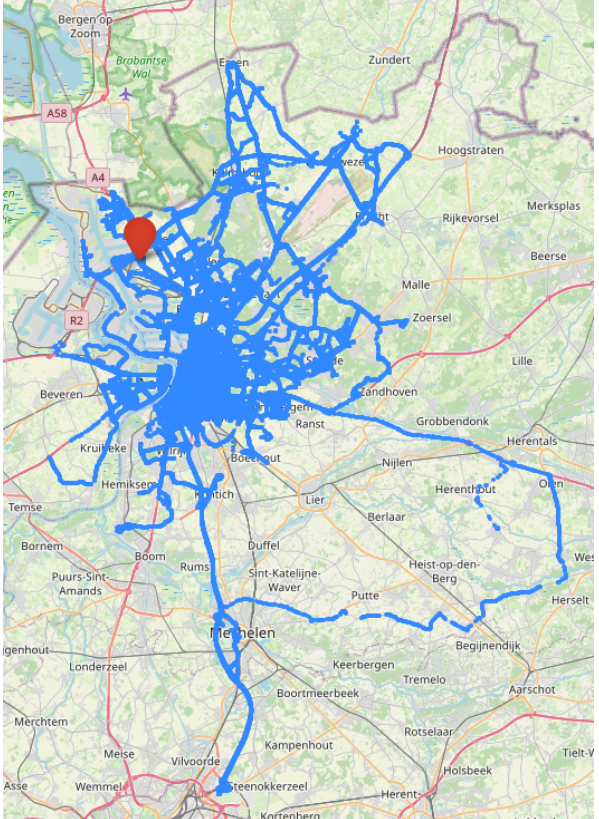
Figure 4. Blue road segments have observations between 19 December 2020 and 1 December 2021. Stabroek RWS is highlighted with a marker.base map and data from OpenStreetMap and the Open- StreetMap Foundation.